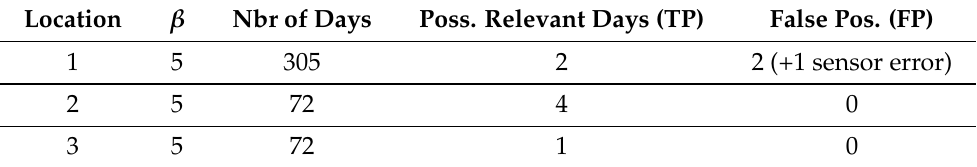
Table 4. Summary of the results for the real-world data. No FN have been reported while interviewing the